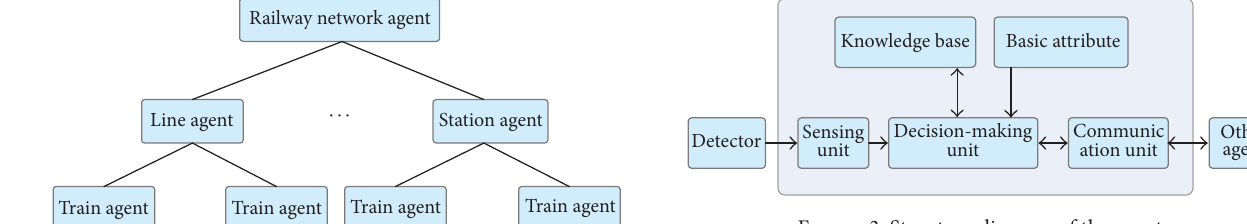
Figure 3: Structure diagram of the